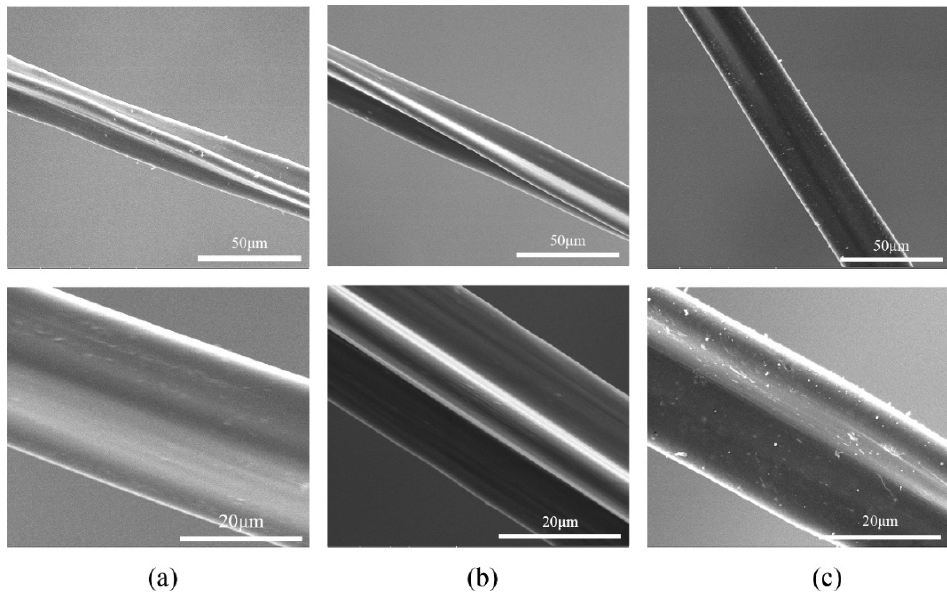
Figure 7. Distribution pattern of resveratrol on the surface of diacetate fiber: ( a ) Untreated diacetate fiber; ( b ) Diacetate fiber treated by SCF-CO 2 at 80 °C, 20 MPa, 90 min; ( c ) Impregnation of diacetate fiber with resveratrol in SCF-CO 2 at 80 °C, 20 MPa, 90 min.